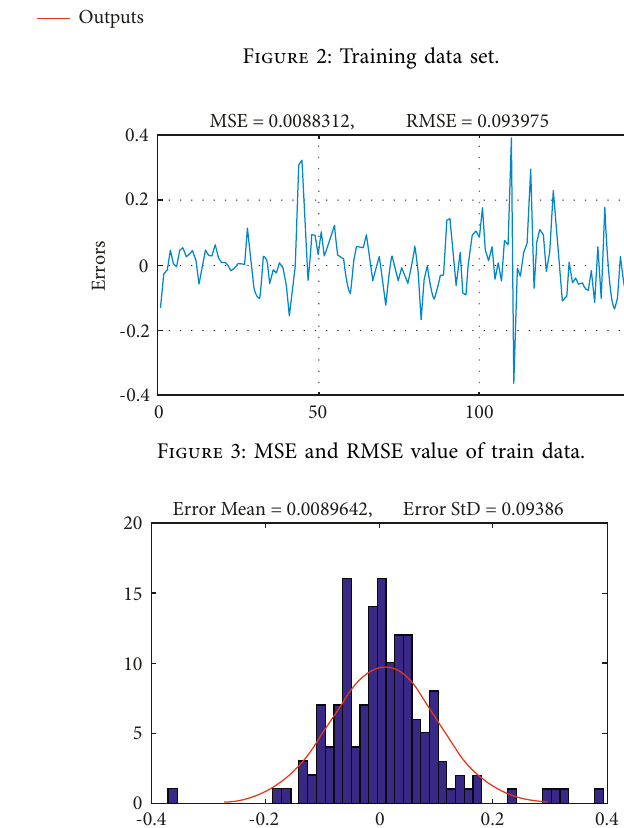
Figure 4: Train data set mean error.